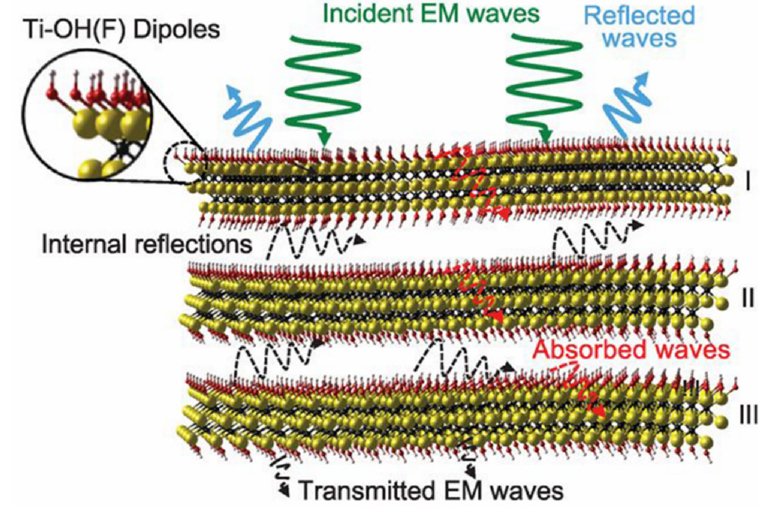
Figure 11. Schematic illustration of EMI shielding mechanism of MXene-SA composite films. Reproduced with permission from ref. [22]. Copyright 2016, the American Association for the Advancement of Science.